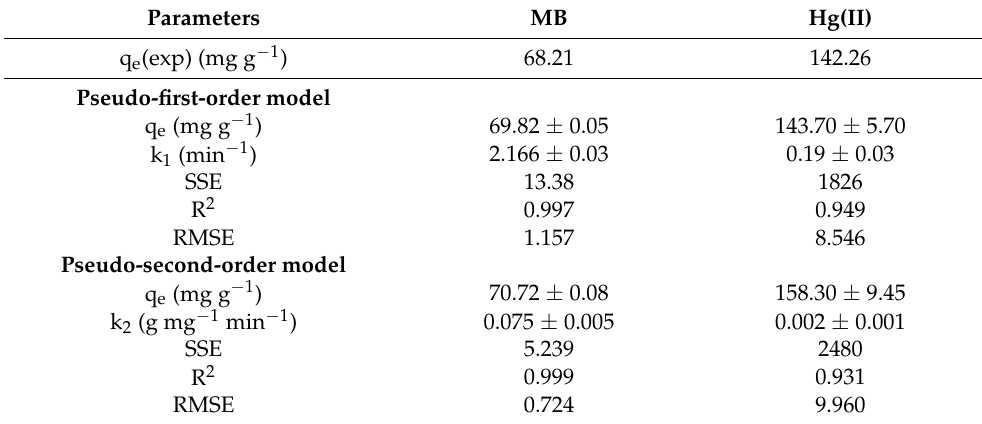
Table 1. Estimated parameters at 298 K of the pseudo-first-order model and the pseudo-second- order model.